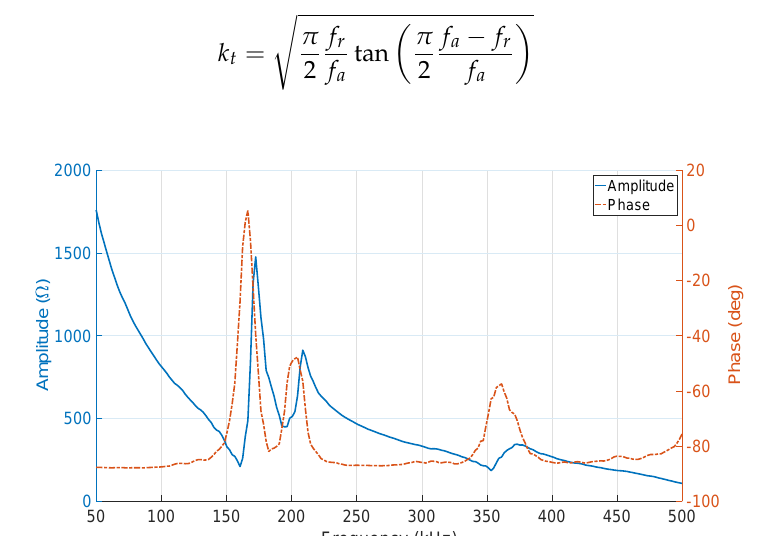
Figure 19. The measured amplitude and phase of the electrical input impedance of the transducer respect to the